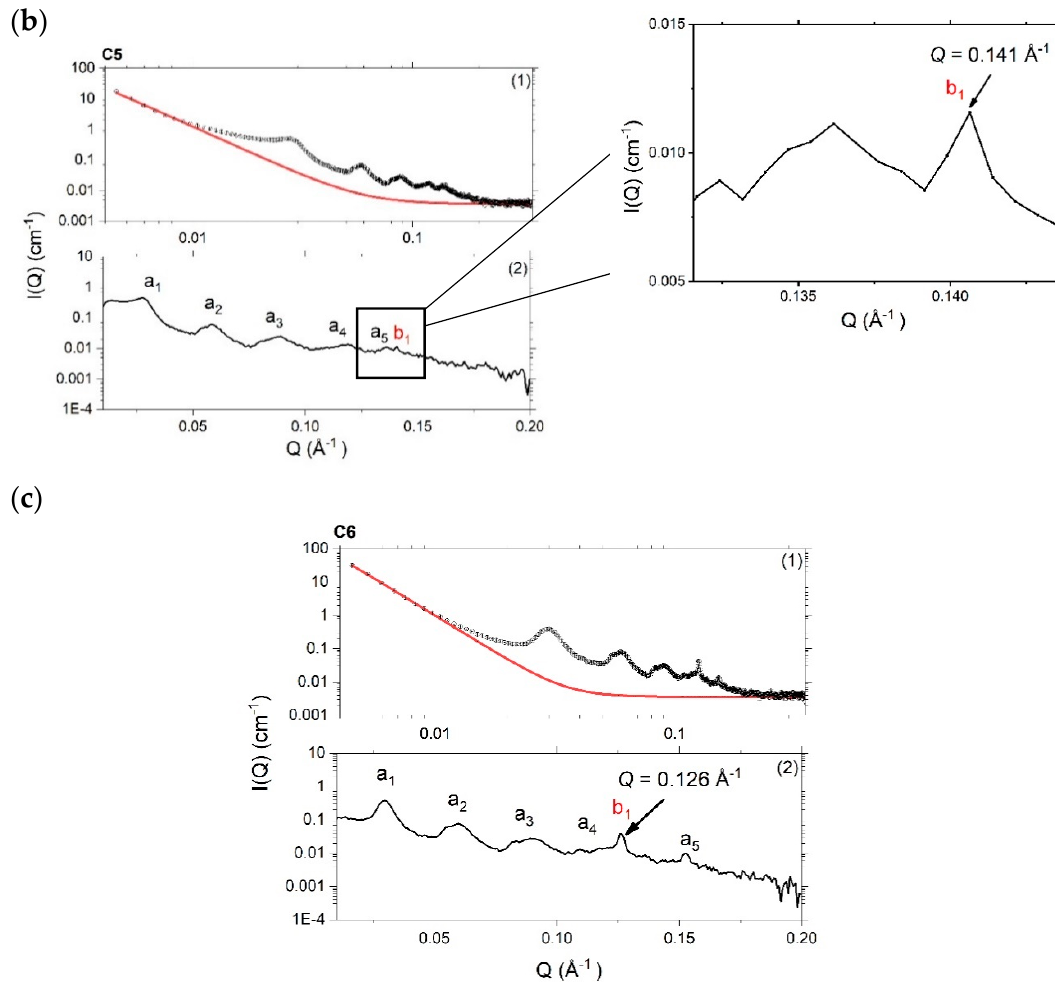
Figure 3. Small-Angle X-ray Scattering (SAXS) profiles recorded at 298 K for 10% creams prepared with a 1:1 ( a ; C4), 1:0 ( b ; C5) or 0:1 ( c ; C6) hexadecanol:octadecanol co-surfactant ratio, with the ( Q − 4 ) Porod scattering model-fitted with a Power law (1; red) and this then subtracted to yield the difference SAXS profile (2). In (2) there are five orders of Bragg reflection (labelled a 1 –a 5 ; black) seen for the long periodicity phase and a single reflection (b1; red) seen for a short periodicity phase. These phases have estimated d -spacings of ~200 Å and either 50 Å (C4 and C6) or 45 Å (C5), respectively. Inset in ( b ) shows the profile enlarged around the peak arising at Q ≈ 0.141 Å − 1 . Error bars on the measured data are subsumed within the plotted symbols. Formulation compositions are as provided in Table 1.